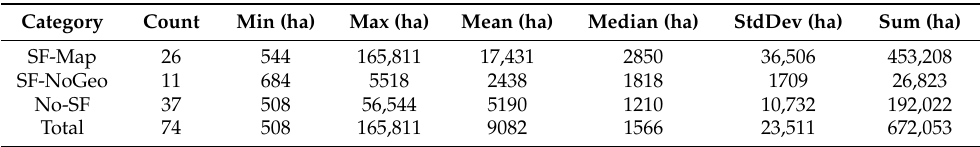
Table 4. Descriptive statistics of fire size by suppression firing category.